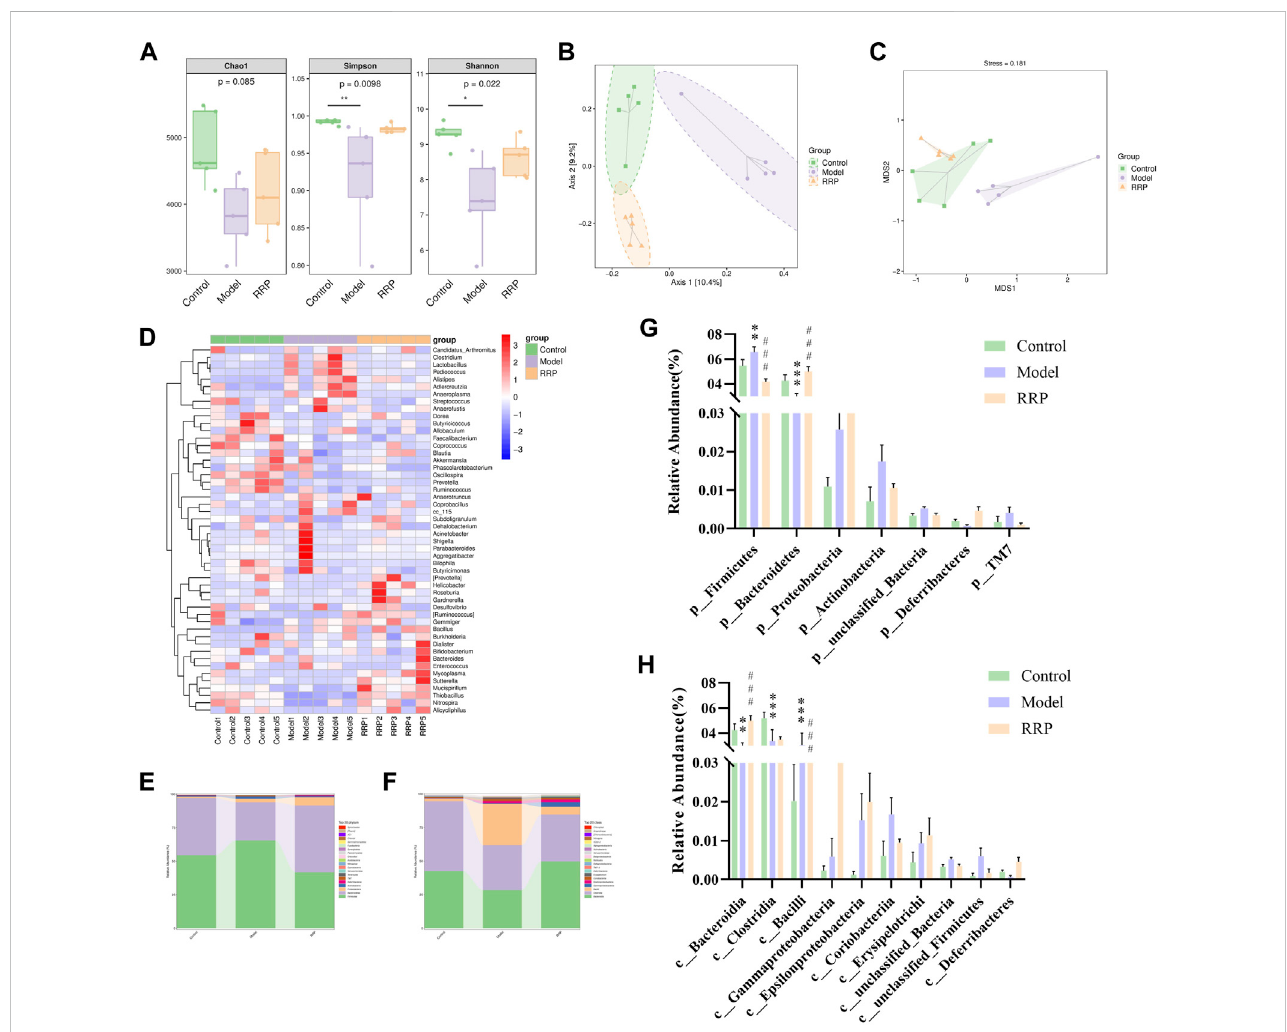
FIGURE 5 Analysis of intestinal microbiota in cecal contents of mice in each group. (A) . Chao1, Simpson and Shannon values of alpha diversity index in each group. (B,C) . PCOA and NMDS analysisof beta diversity; (D) . Genus-level species composition heatmap for species clustering. The red colorblocksrepresent theabundanceofthegenusthatishigherinthissamplethaninothersamples,andthebluecolorblocksrepresenttheabundanceofthegenus,thatis,lowerin this sample than in other samples; (E – H) . Bar graph of species composition at the phylum, class